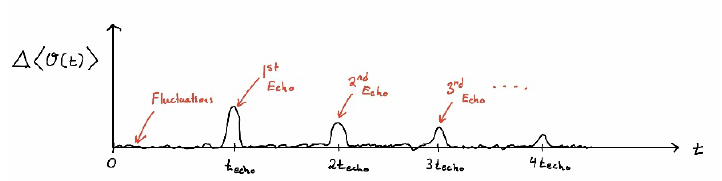
Figure 6 . A diagram depicting how echoes will manifest themselves in a calculation involving (cid:1) h ^ O ( t (cid:0) t 0 ) i . Initially, the di(cid:11)erence in the expectation value of the operator is subject to small (cid:13)uctuations around zero. After one echo time scale, one would (cid:12)nd a distinct signal above the usual (cid:13)uctuations represented by the (cid:12)rst peak. This signals the (cid:12)rst echo in the bulk. This would re(cid:13)ect o(cid:11) the boundary and go back towards horizon and the process would repeat except subsequent echoes would gradually weaken (depicted by subsequent peaks with smaller amplitude). 0 < t (cid:0) t < t . Once the re(cid:13)ected perturbation hits the boundary there should be a big 0 echo di(cid:11)erence between h j ^ O ( t ) j i and h BH j ^ O ( t ) j BH i roughly of the order O [ h j ^ O ( t